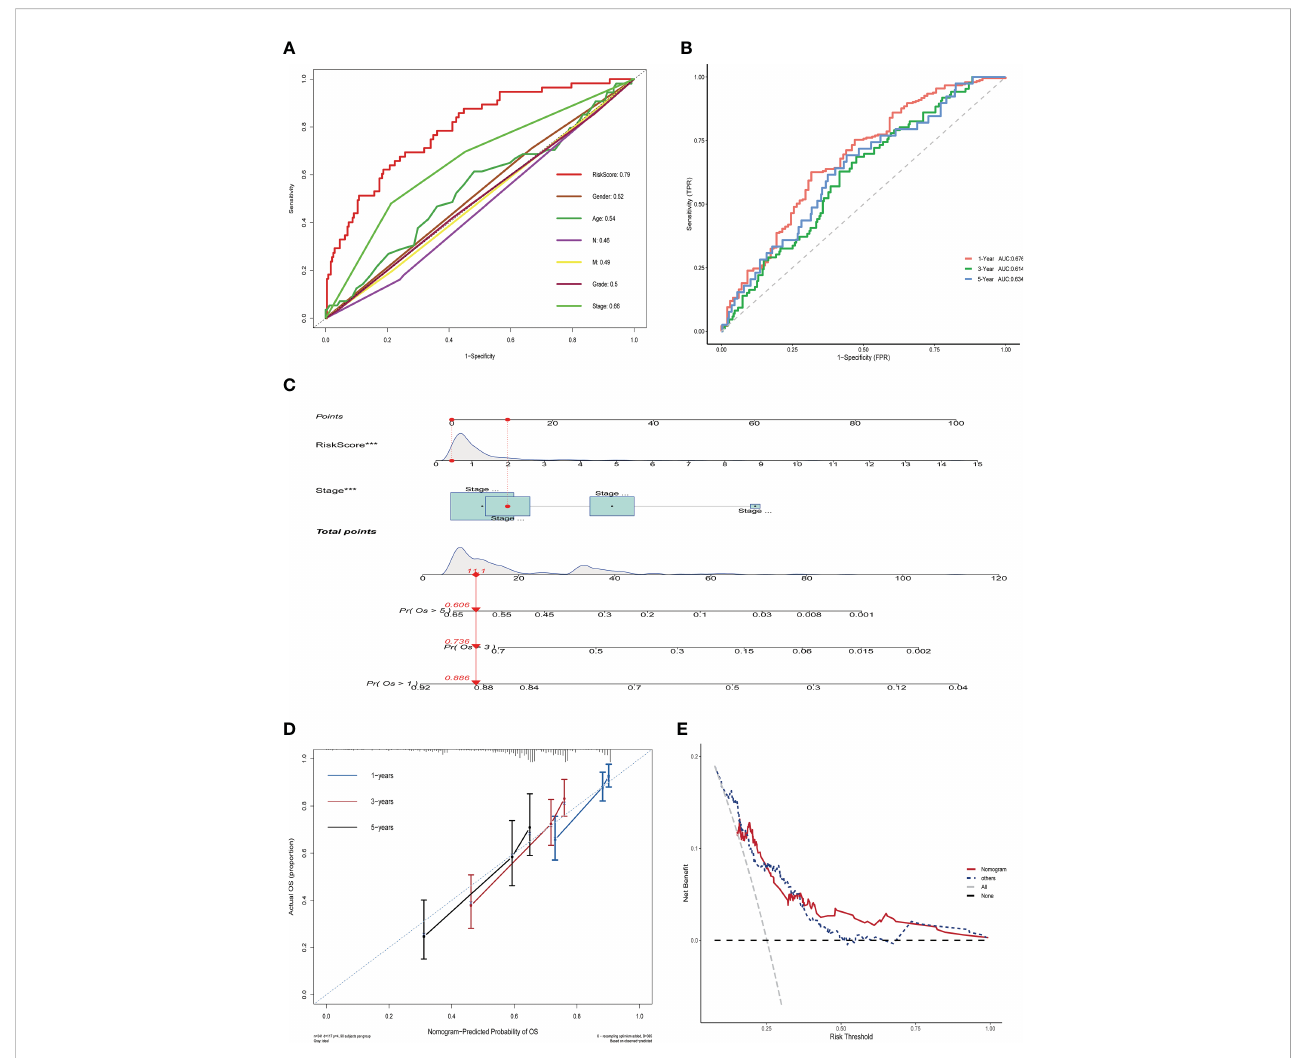
FIGURE 4 Nomogram construction and validation in TCGA LIHC dataset. (A) ROC curves showing the comparative results of risk scores and other clinical factors for prognostic prediction. (B) ROC curves showing the results of nomogram for predicting 1-, 3-, and 5-year survival in HCC patients. (C) Nomogram constructed from Stage and risk score. (D) Calibration curves show strong predictive power of nomogram for 1-, 3-, and 5-year survival in HCC patients. (E) Decision curves show that the nomogram model outperforms other